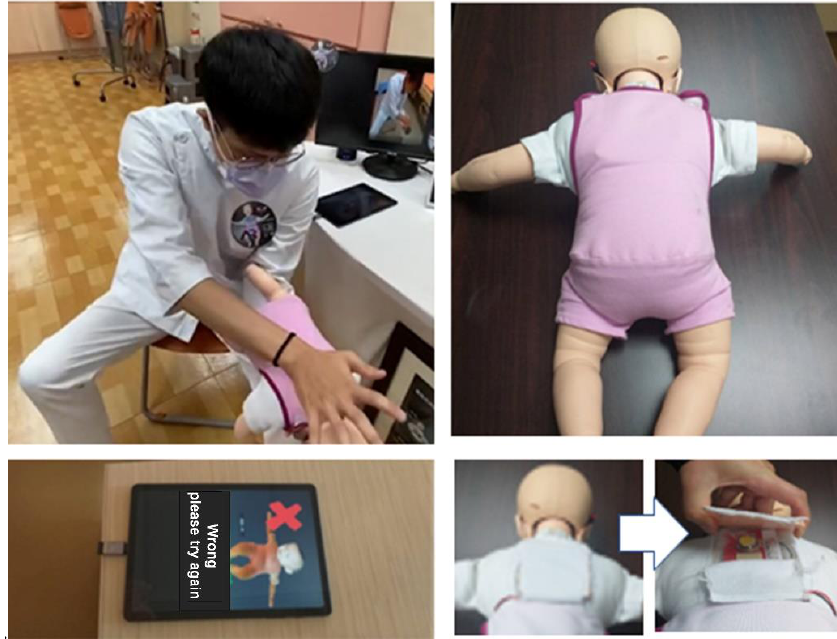
Figure 2. A pressure sensor for detecting back slaps.